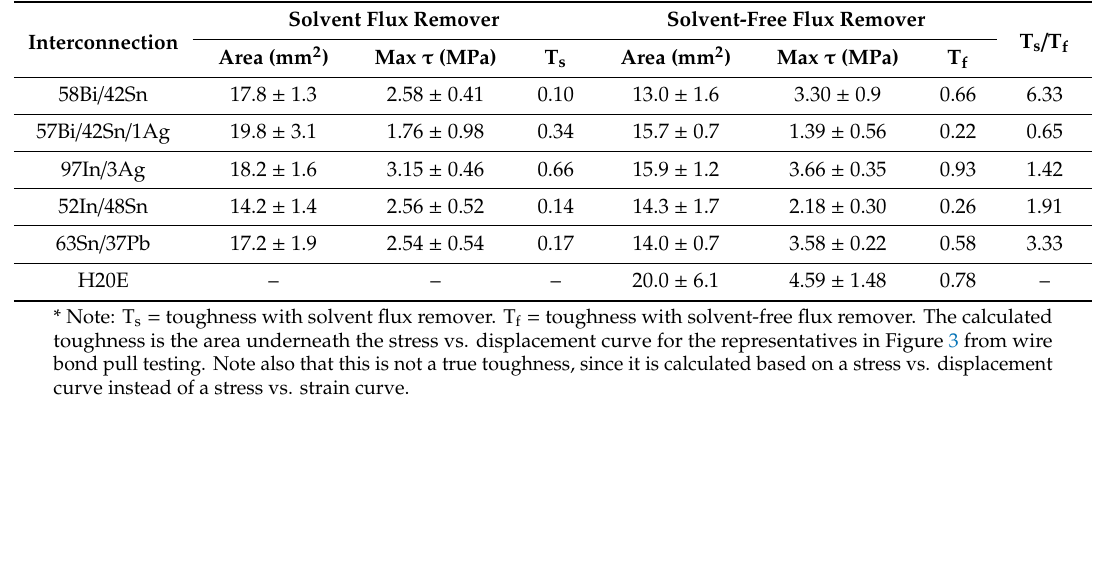
Table 3. Wire bond pull testing results for copper CB230 conductive